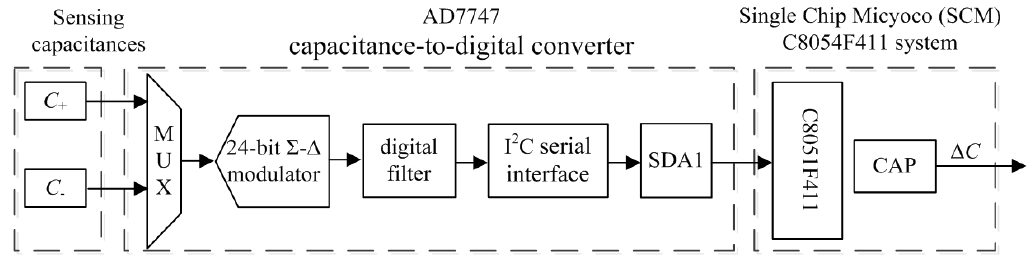
Figure 2. Function module for optimized interface circuit.